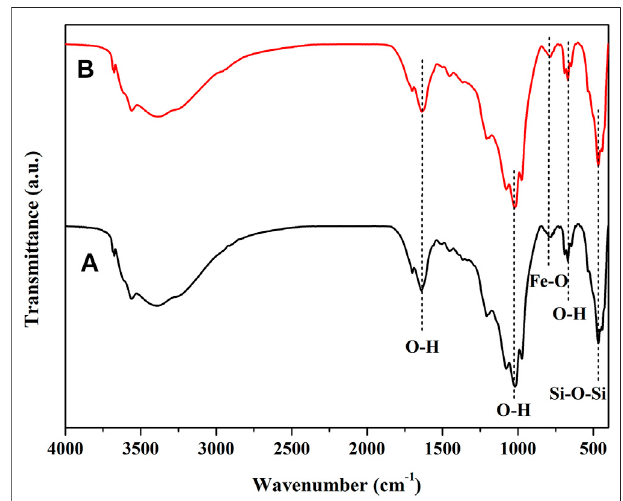
FIGURE 9 | Pseudo- fi rst-order kinetic curve of TC-HCl degradation. (Experimentalconditions:TC-HClconcentration (cid:1) 20 mg/L,catalystdosage (cid:1)